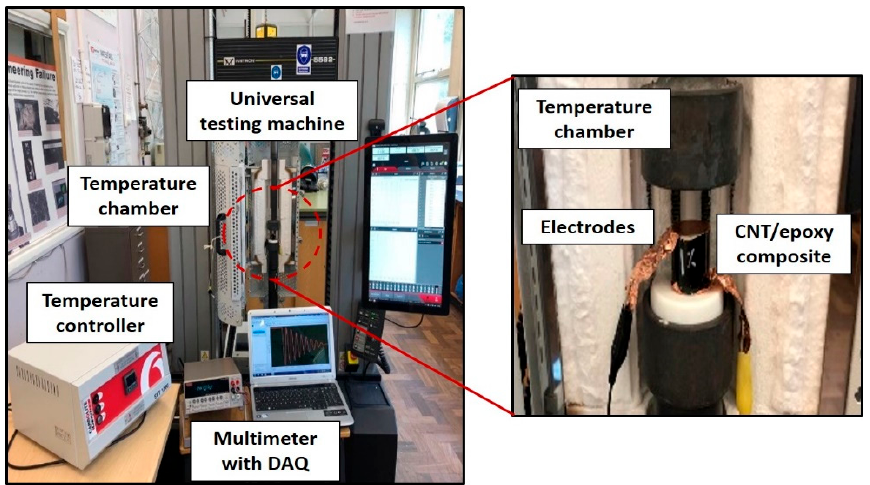
Figure 1. Electro-thermo-mechanical test set-up.